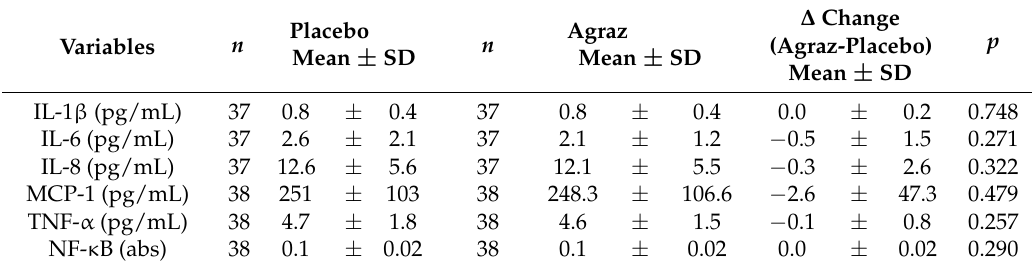
Table 3. Inflammation markers after 4 weeks placebo and agraz consumption.